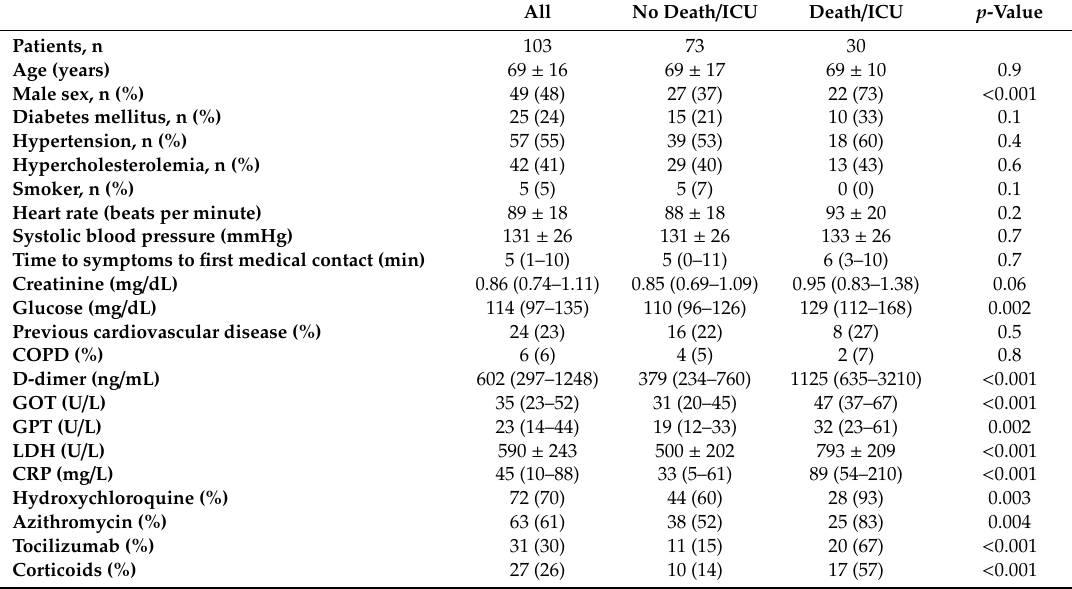
Table 2. Baseline characteristics of COVID-19 patients with and without adverse events (death / ICU